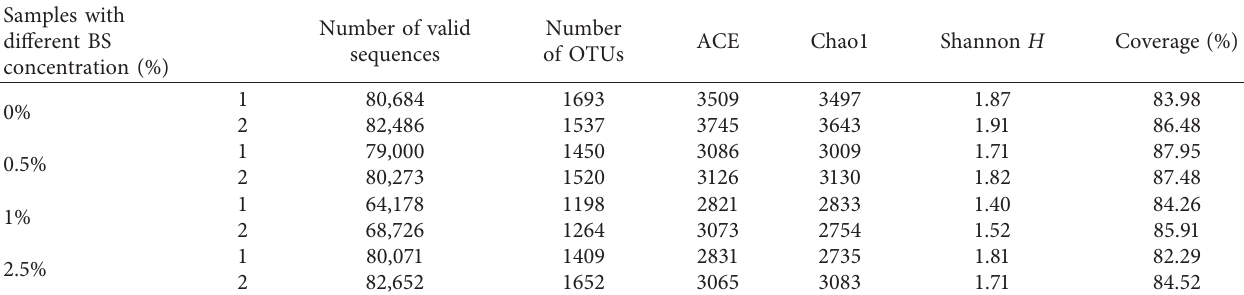
Table 6: Number of OTUs, richness estimators ACE and Chao1, and Shannon diversity index H for bacterial communities inside mortars with different biosurfactant (BS)